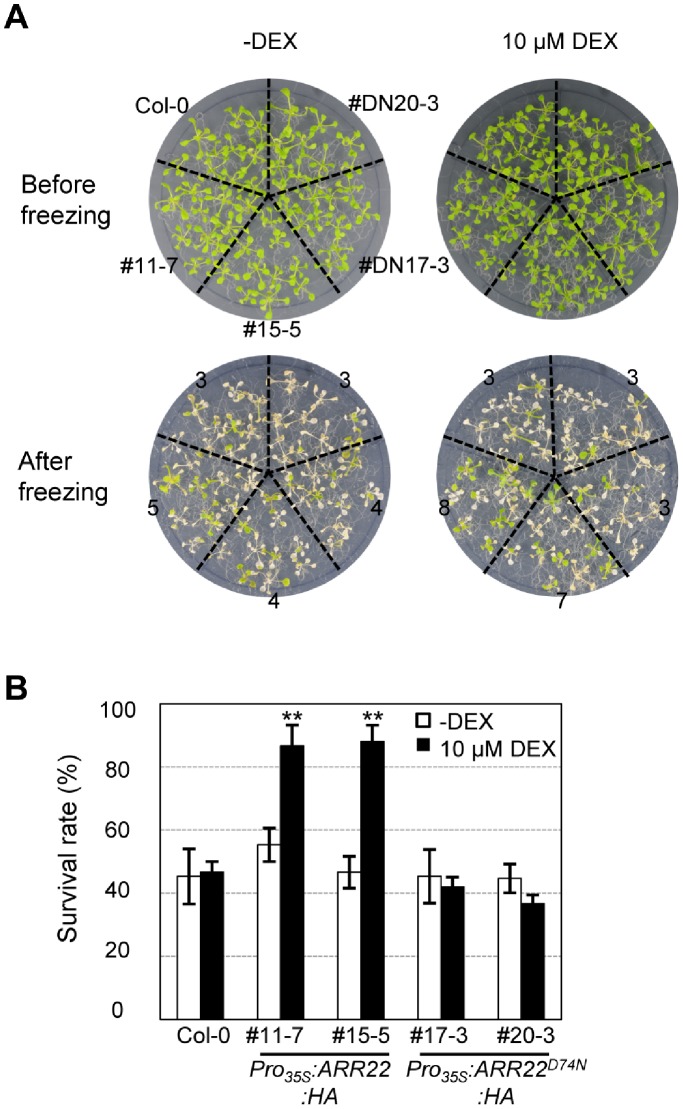
Freezing tolerance assays of Pro35S:ARR22:HA and Pro35S:ARR22D74N:HA transgenic Arabidopsis plants treated with or without DEX.(A) Representative plates showing plants subjected to freezing tolerance assays. Seedlings were grown and treated with DEX as described in Figure 1D. These plants were then treated at −4°C for 4 h and 20 min and photographed after 3 d of incubation at 23°C for recovery. One plate (ø150 mm × 20 mm) contained 10 plants per each plant sample. Three plates were used for each experiment. # and #DN indicate line numbers of Pro35S:ARR22:HA and Pro35S:ARR22D74N:HA transgenic plants. (B) Plants surviving after freezing stress. Plants were treated as described in Figure 5A. The percentage of plants that survived was calculated. Experiments were conducted five times, and the mean values and standard errors are plotted; n = 30. A statistical analysis was conducted as described in Figure 2B.